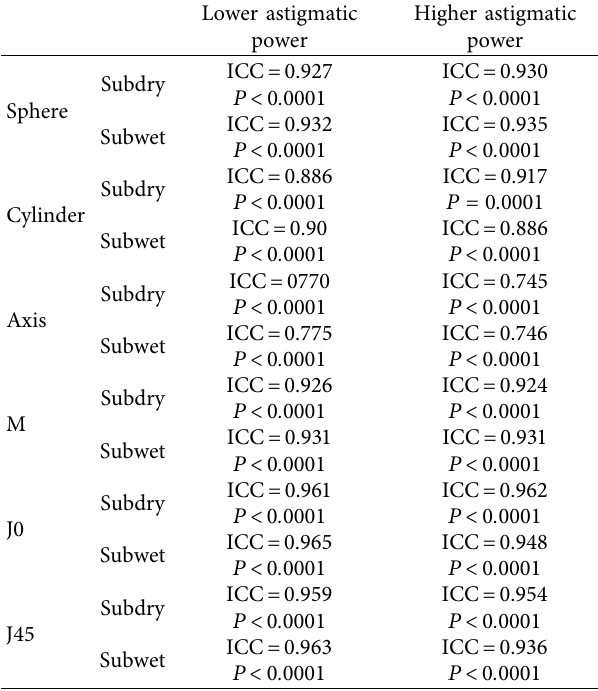
Table 3: Intraclass-correlation coefficient between subjective re- fraction for sphere, cylinder, axis, M, J0, and J45.